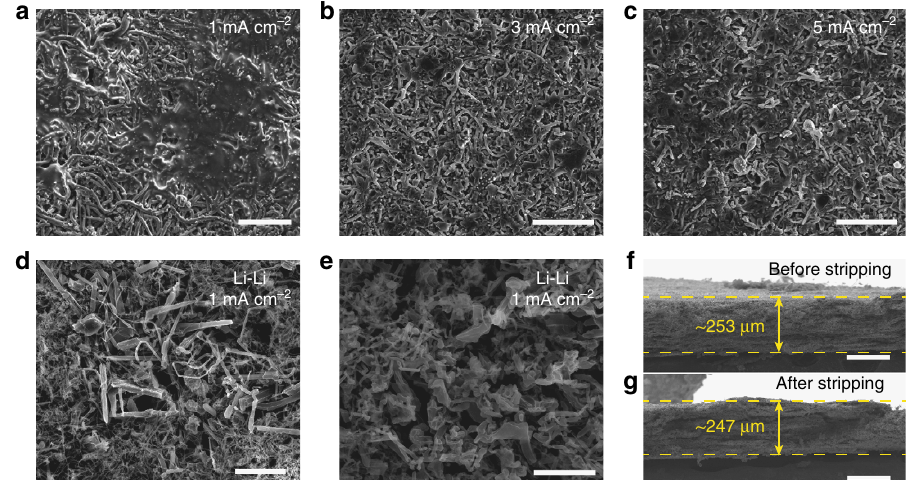
Figure 4 | Morphology of the Li electrodes after cycling at different current densities. Top-view SEM images of the Li-coated PI matrix after 10 cycles of stripping/plating in EC/DEC at a current density of ( a ) 1mAcm (cid:2) 2 , ( b ) 3mAcm (cid:2) 2 and ( c ) 5mAcm (cid:2) 2 . ( d , e ) Top-view SEM images of the bare Li electrode after 10 cycles of stripping/plating in EC/DEC at a current density of 1mAcm (cid:2) 2 with large amounts of mossy Li dendrites. Cross-sectional SEM images of the Li-coated PI matrix ( f ) before and ( g ) after complete Li stripping, from which no significant volume change can be seen. (Note that the uniform fibrous features in a – c are not dendrites but the fibrous matrix, which are distinctly different from the non-uniform, random-sized mossy Li dendrites in d , e ). Scale bars, ( a – d ) 10 m m, ( e ) 5 m m, ( f , g ) 200 m